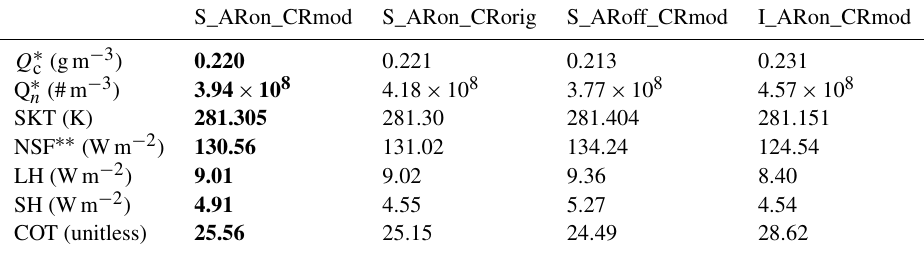
Table 5. Mean values of cloud liquid water ( Q c ), cloud droplet number ( Q n ), surface skin temperature (SKT), net shortwave flux (NSF), latent heat flux (LH) and sensible heat flux (SH) for four experiments over the entire Central Valley during 16 to 18 January 2011. The bold font indicates the base